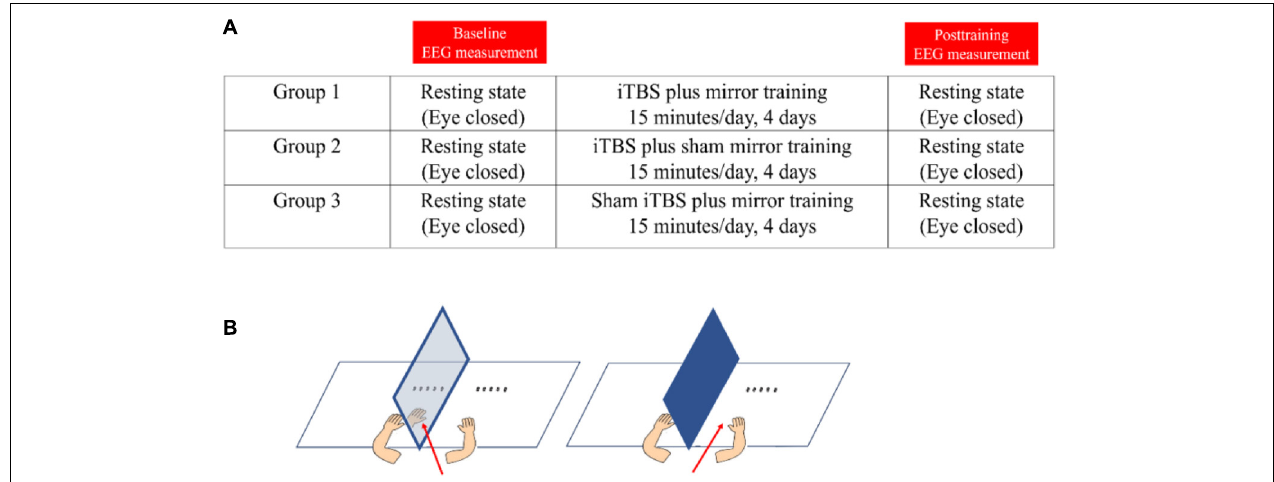
FIGURE 1 | The demonstration of study design and intervention. (A) The study procedure. (B) Demonstration of mirror training (left-side) and sham mirror training (right-side). The red arrow denotes the visual direction during the